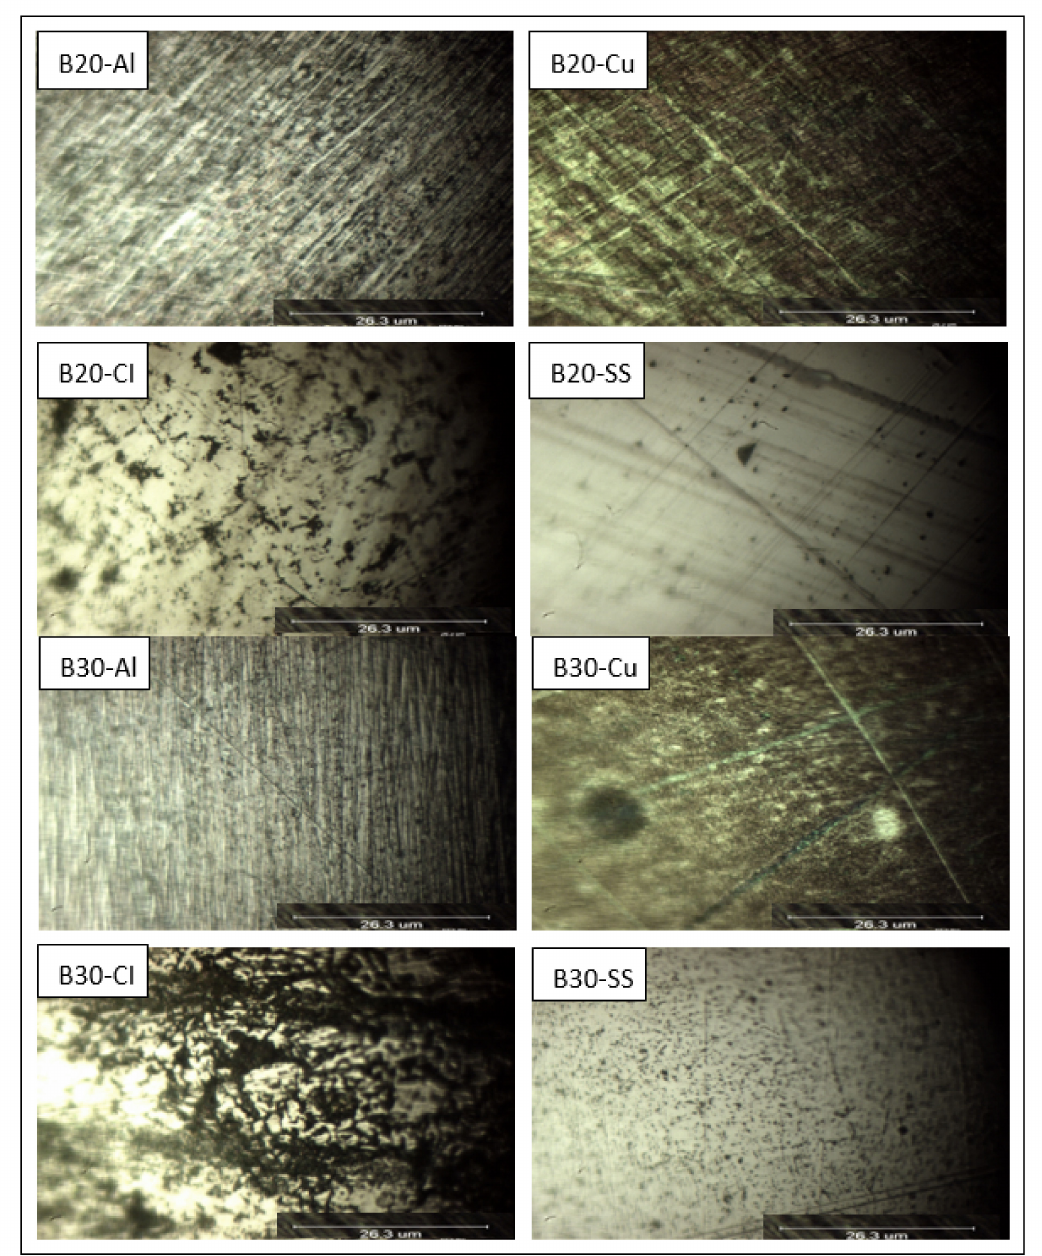
Figure 3. Optical micrograph (magnification: 500 × ) of different materials after the immersion test immersed into